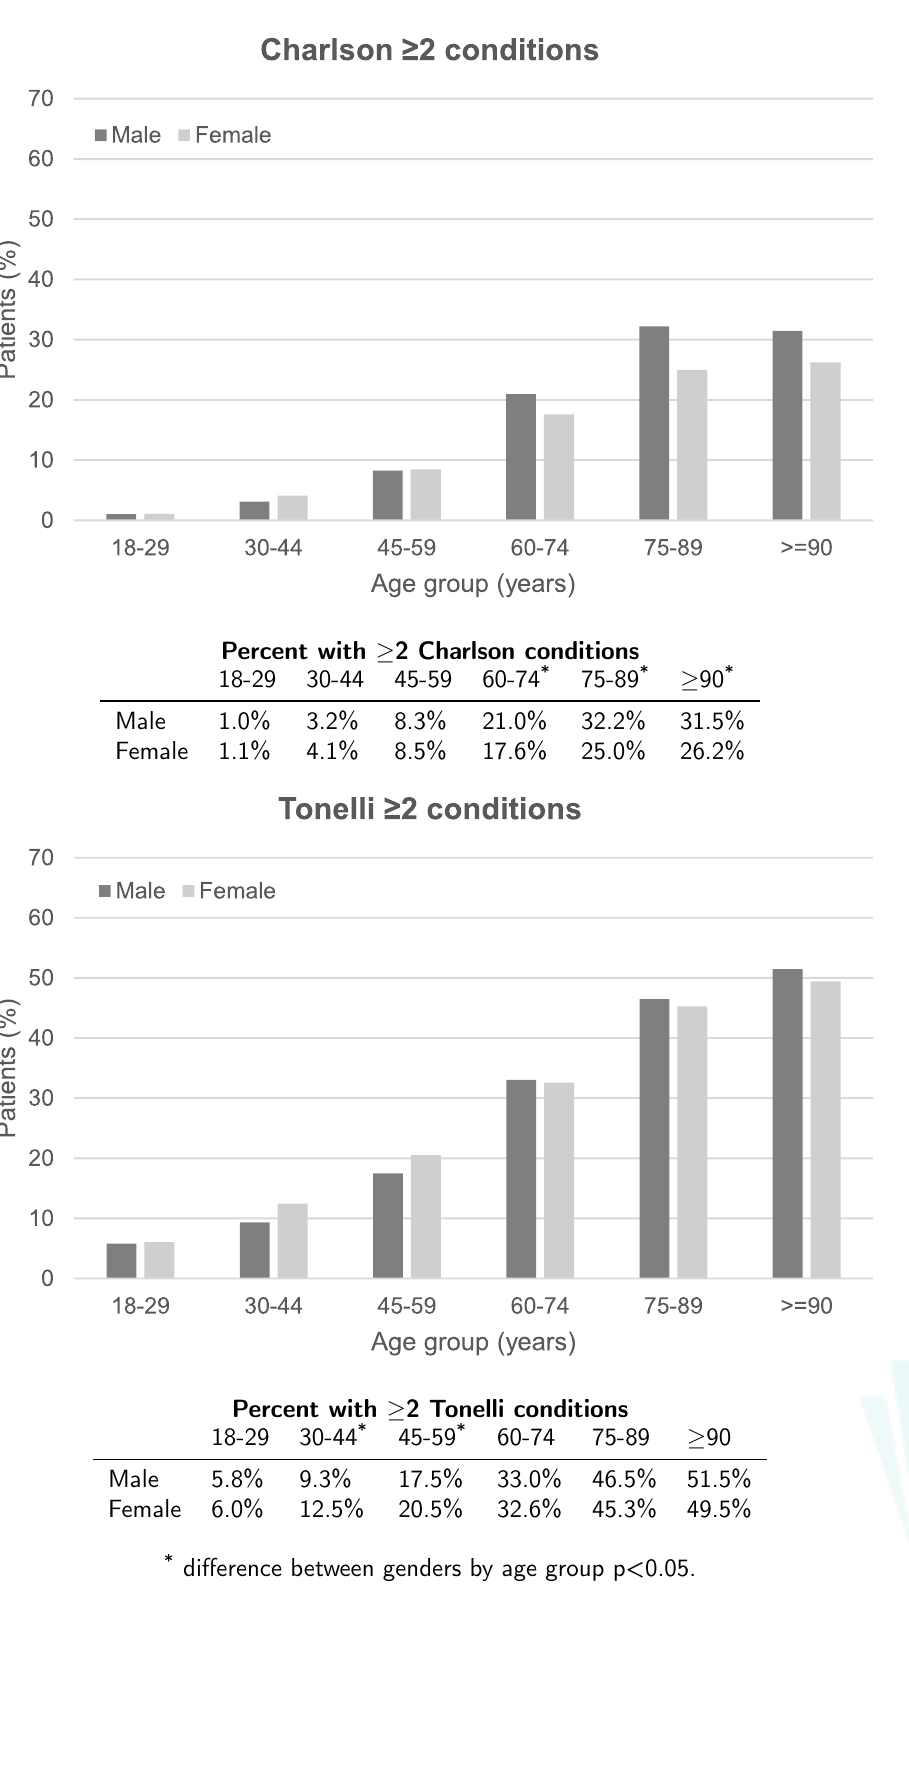
Figure 3: Prevalence of multimorbidity by age and